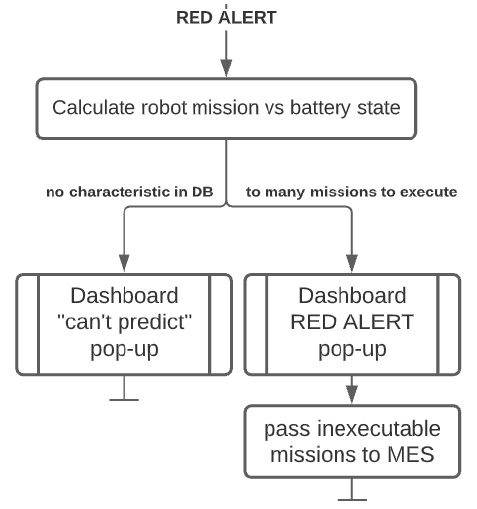
Figure 10. Red alert functionality algorithm.